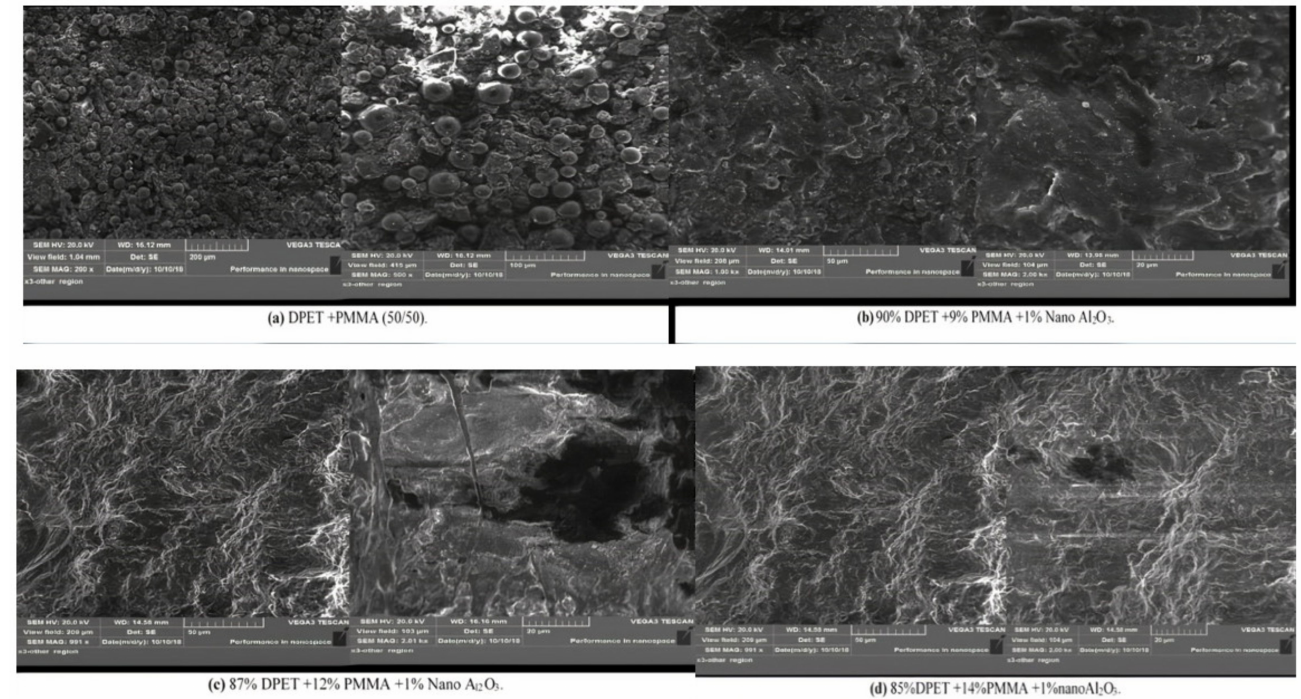
Figure 4. SEM micrograph of different blends’